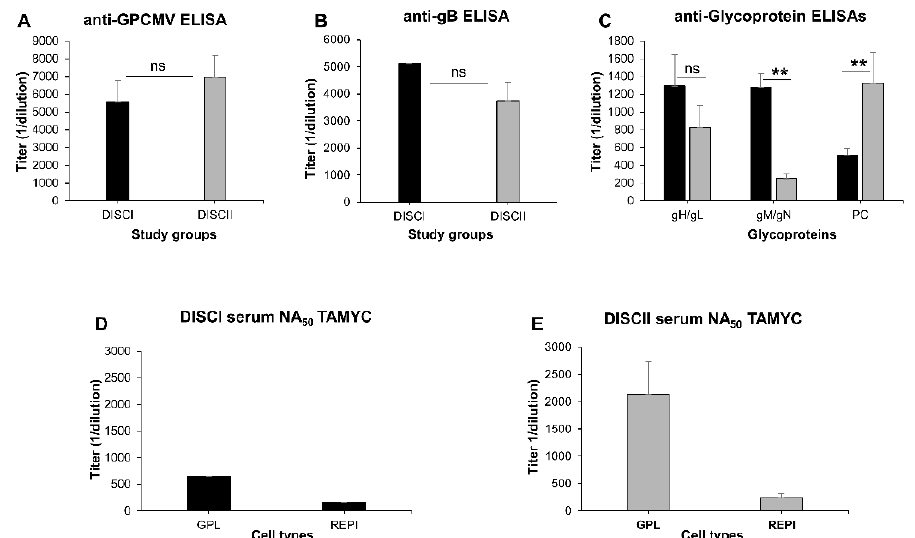
Figure 1. Comparative immune responses to DISC vaccine (DISCI vs. DISCII) and GPCMV (TAMYC strain) neutralization on fibroblast and epithelial cells. ( A – C ) Immune response of DISCII animal sera was compared to that of previous historical DISCI pooled sera from animals vaccinated with identical protocol [38]. ( A ) Anti-GPCMV ELISA titer; ( B ) anti-gB glycoprotein ELISA titer; ( C ) anti-glycoprotein complex ELISA titers (gH/gL, gM/gN, PC) from sera of DISCI (black) or DISCII (gray) vaccinated animals. Neutralizing antibody titers (NA 50 ) against TAMYC strain virus on GPL (fibroblast) or REPI (epithelial) cells of pooled sera from either DISCI animals ( D ) or DISCII-vaccinated animals ( E ). Mean ELISA and neutralization values are a result of assay triplicates with each sample run a minimum of three independent times. Statistical analysis was determined by unpaired Student’s t test; ** p < 0.005; ns =